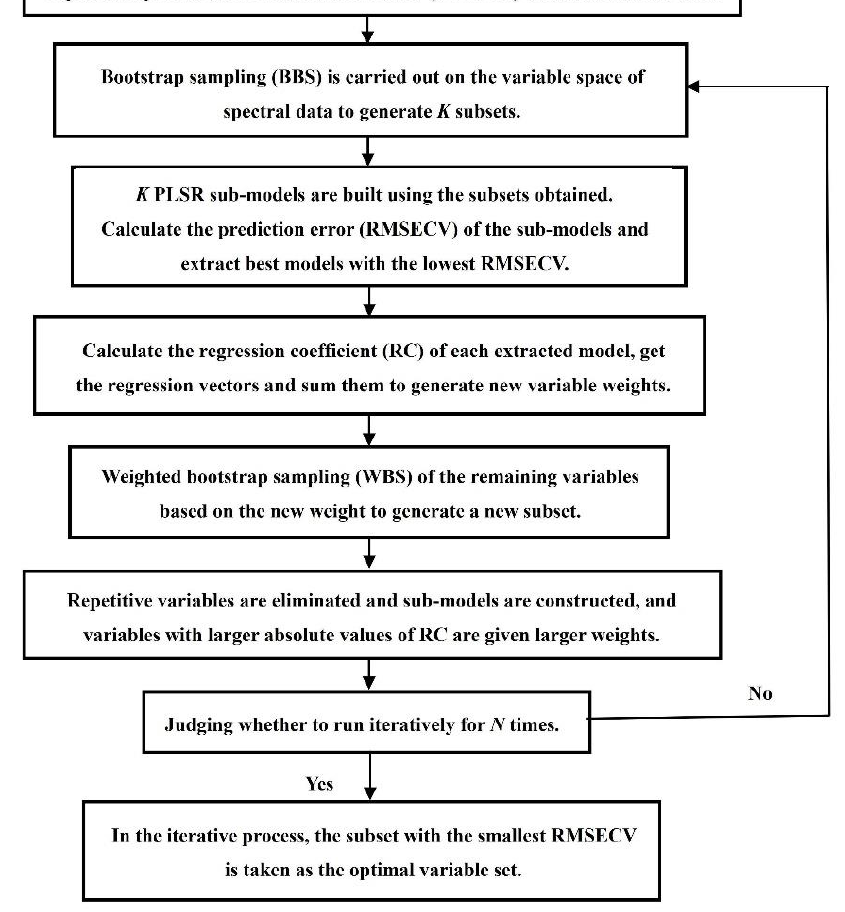
Figure 4. The flow chart of the BOSS method.